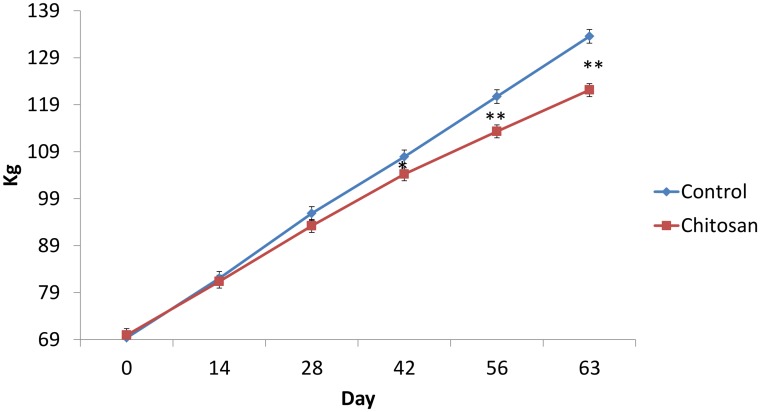
Effect of dietary supplementation on body weight over time at days 0, 14, 28, 42, 56 and 63.*P<0.05 **P<0.001 Treatment effect P< 0.001. Time effect P< 0.001. Time x treatment effect P< 0.01. Values are means, with their standard errors represented by vertical bars.